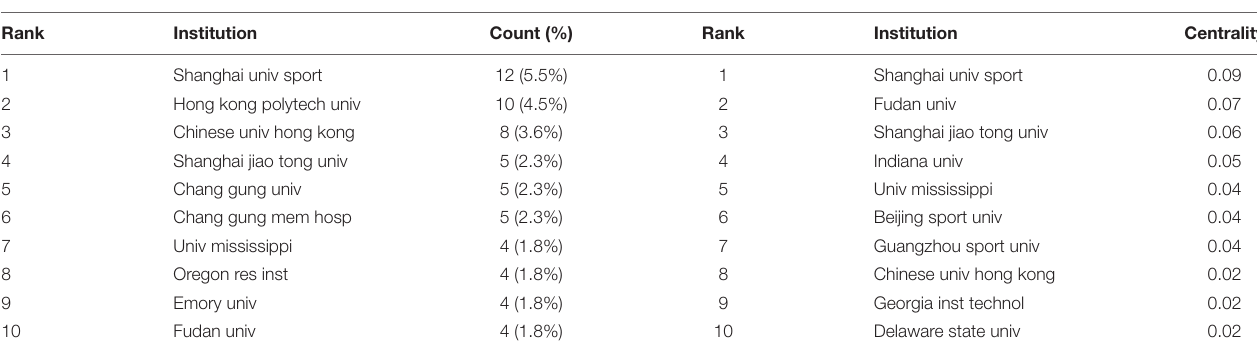
FIGURE 3 | Collaboration network of institutions. The nodes in the map represent institutions, and lines between the nodes represent collaborative relationships. The size of the node area shows the number of co-citations. The colors in the nodes represent the years. The purple ring represents centrality. TABLE 3 | Top 10 institutions in terms of publications and